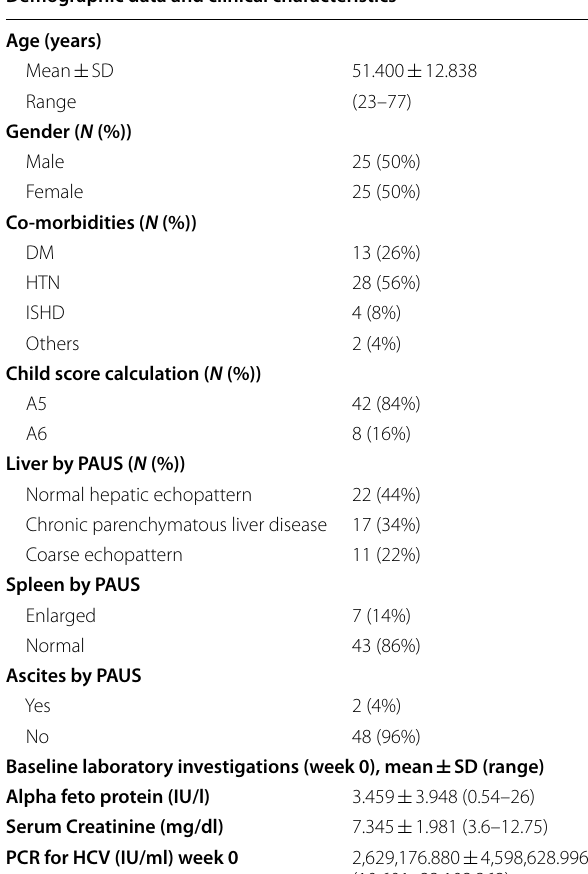
Table 1 Demographic data and clinical characteristics of the study